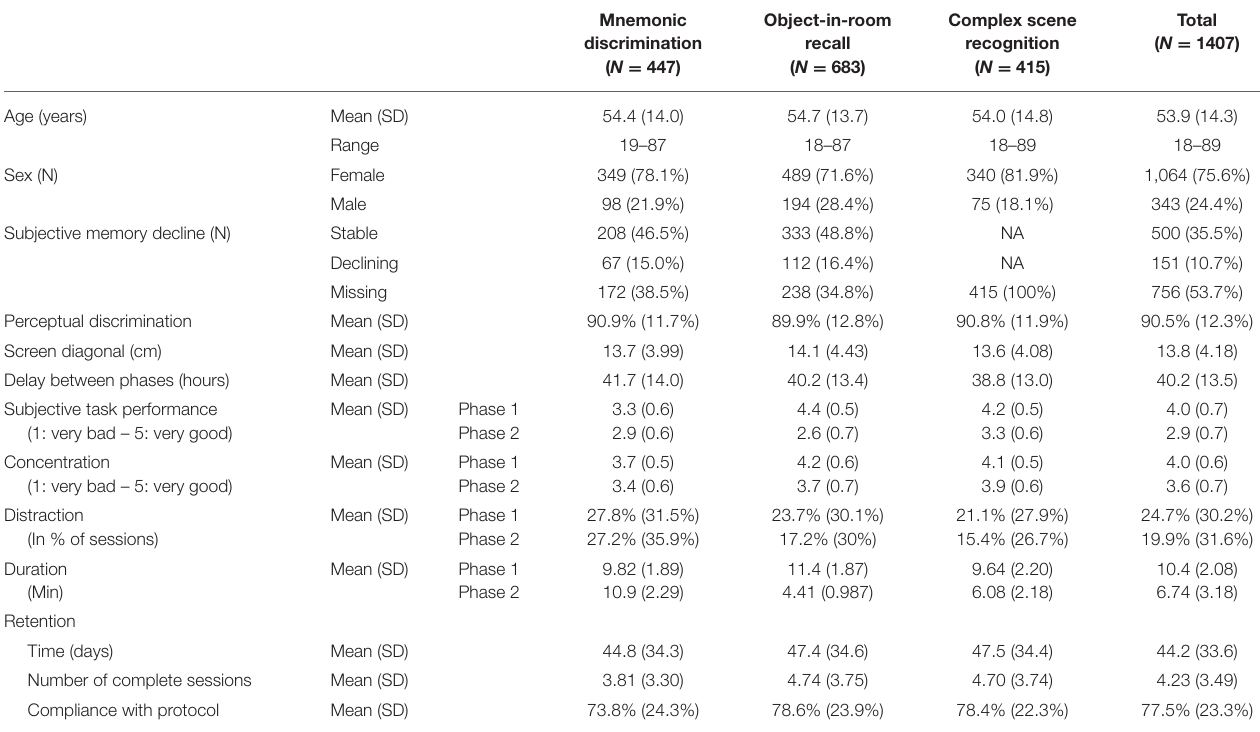
TABLE 1 | Demographics, task-specific questionnaire data, and